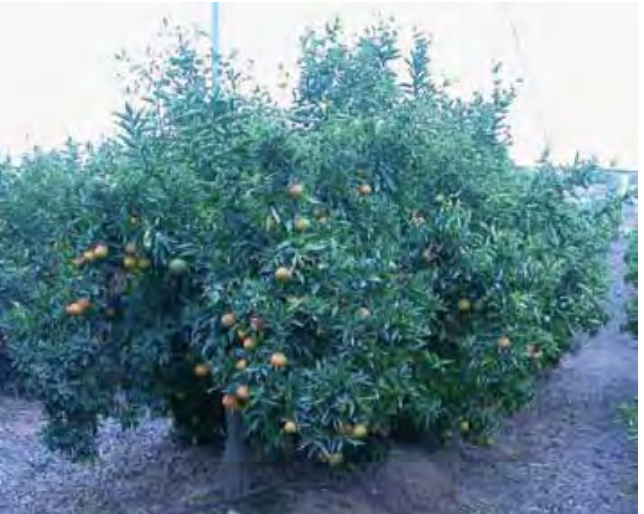
Fig. 5 - Clementine tree.